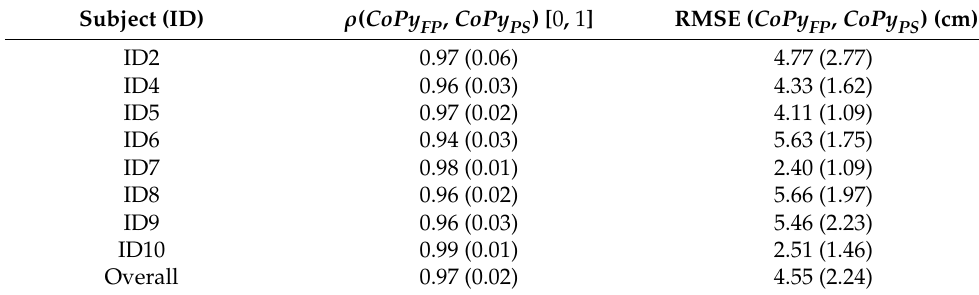
Table 4. Median (IQR) of the correlation coefficients and RMSE between the CoPy estimated by the pressure sensors ( CoPy PS and the one recorded from the force platform CoPy FP for each subject involved in the experimentation